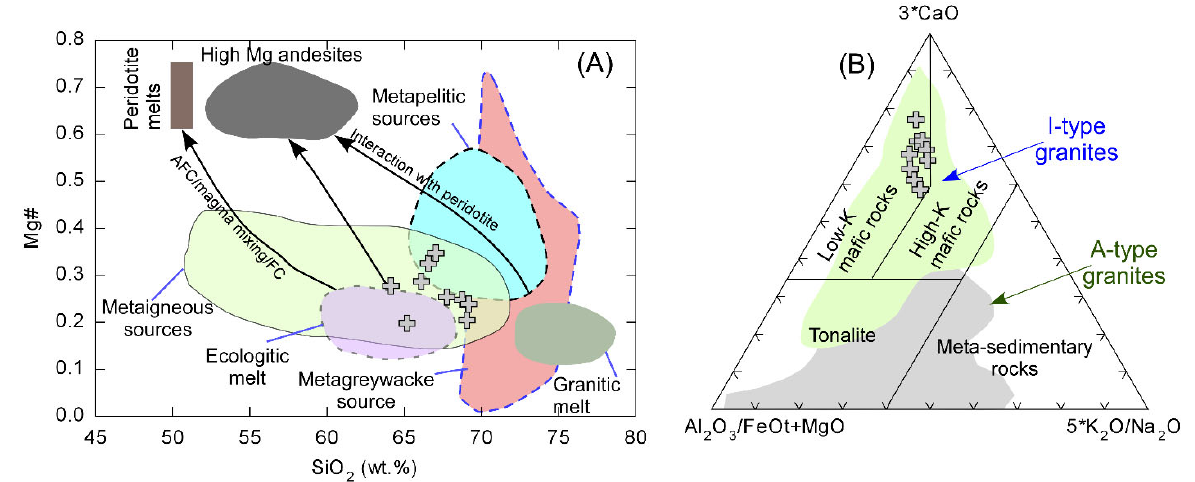
Figure 10. ( A ) SiO 2 versus Mg# diagram (reference fields represent experimentally dehydration melting data of different sources under crustal P (0.5–1.5 GPa) and (800–1000 °C) values after Patiño Douce, [62]; Wolf and Wyllie, [63]); and ( B ) Ternary diagram of Al 2 O 3 /(FeO t + MgO) − 3*CaO − 5*(K 2 O/Na 2 O) [64], showing that the Haweit granodiorite were likely derived from a low ‐ K mafic magma source. The fields of A ‐ type and I ‐ type granites from the ANS are adopted from Robinson et al. [65,66].